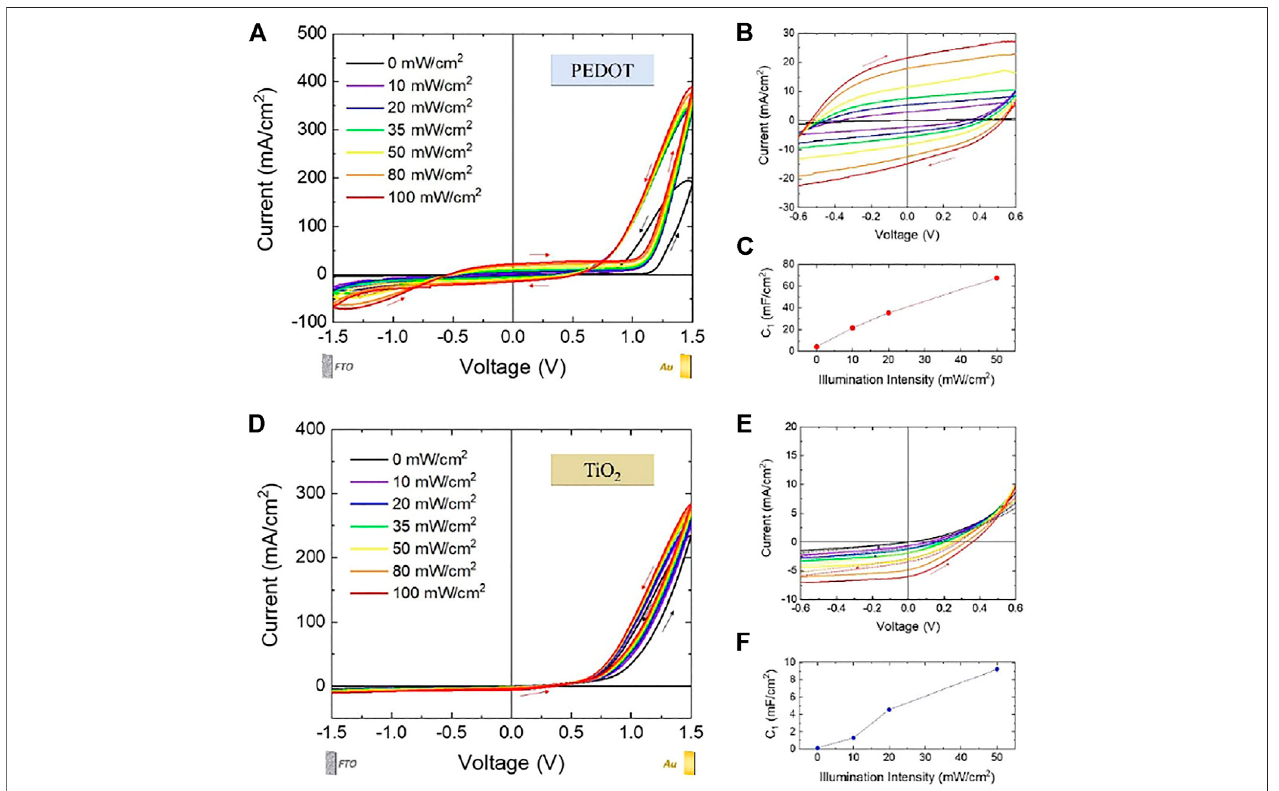
FIGURE 10 | (A) Current density – voltage characteristic of an FTO/PEDOT:PSS/MAPI/Au memristor measured from 0 to 100 mW/cm 2 using a blue light source (470 nm) and 0.1 cm 2 active area. (B) A magni fi ed view of the scale. (C) Low-frequency capacitance enhancement with illumination intensity for an FTO/PEDOT:PSS/ MAPI/Au memristor. (D) The current density – voltage characteristic of an FTO/c-TiO 2 /m-TiO 2 /MAPI/Au memristor was measured at different illumination intensities. Panel. (E) corresponds to a magni fi ed view of the scale. Lines represent the forward scan and dots represent the reverse scan. (F) Corresponding low-frequency capacitance variation with illumination